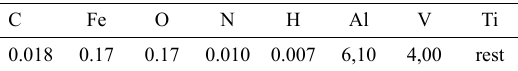
Table 1. Weight percent (wt.%) of each element in the current